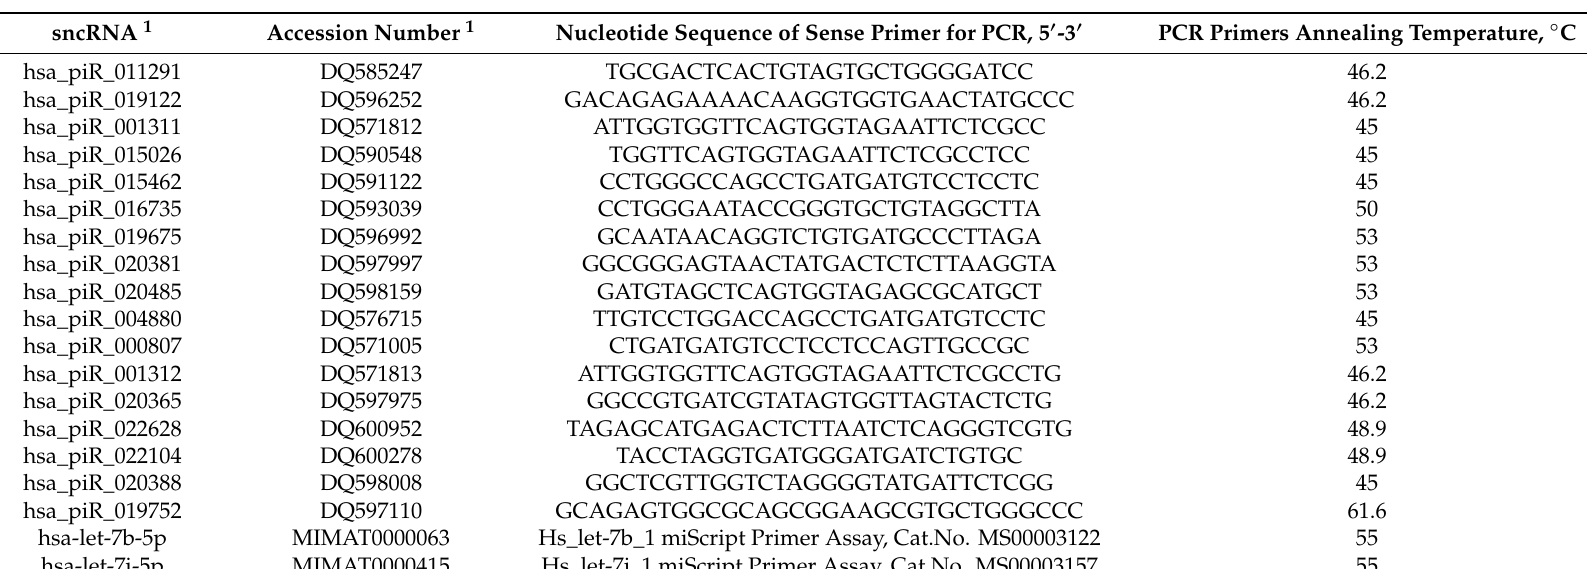
Table 3. sncRNA sequence data.